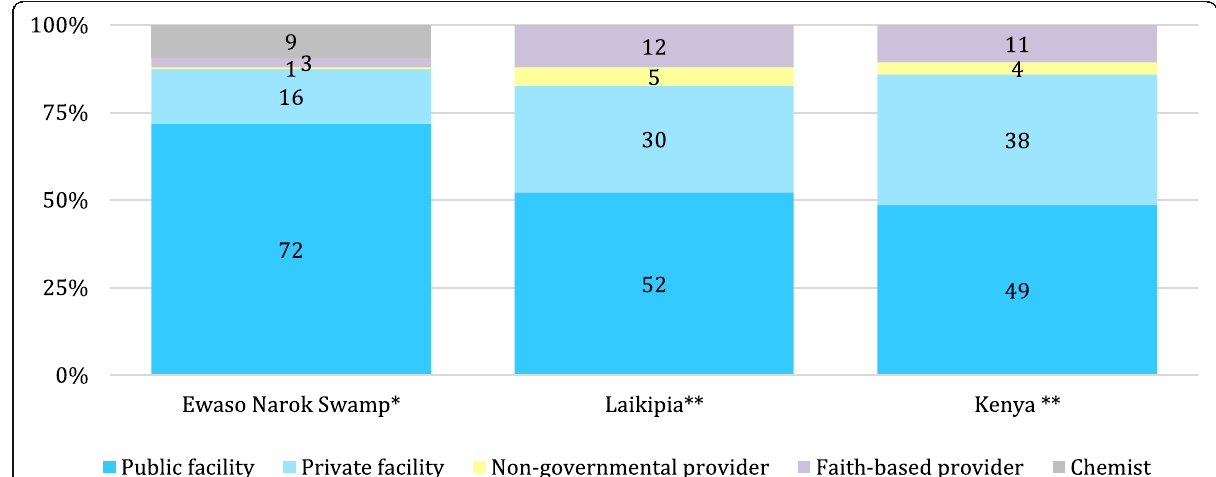
Fig. 6 Health-seeking in the wetland compared to county and national level. * Health-seeking during last self-reported symptom in the Ewao Narok Swamp, own data (2015); ** National data on the district Laikipia and on the national level in Kenya, provided by the Ministry of Health (2015)